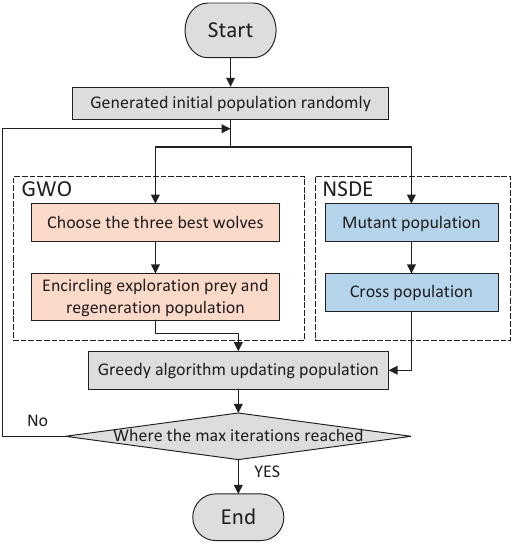
Figure 3. Flow chart of NSDE-GWO hybrid algorithm.